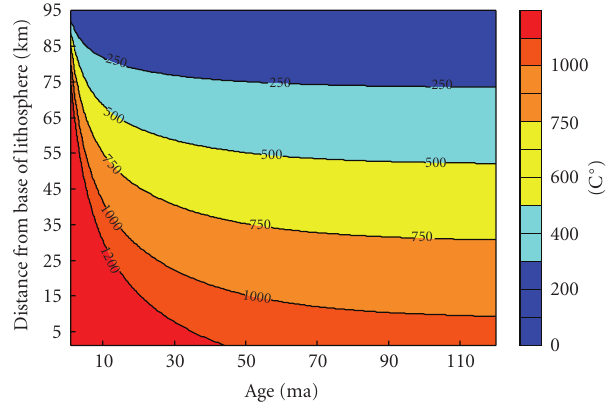
Figure 3: Distribution of isotherms in the oceanic lithosphere, derived from the VBA model of the present work. The numbers on the curves are temperatures in degrees centigrade.